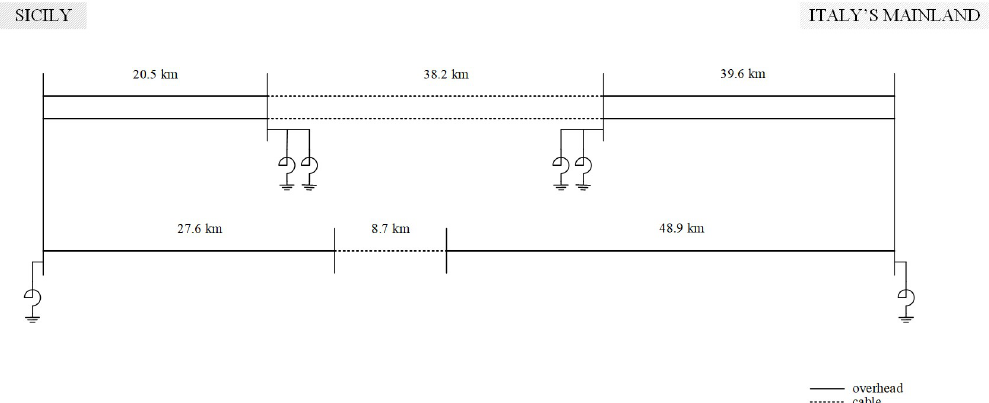
Figure 7. Single line diagram of existing 400 kV interconnections between Sicily and Italy’s mainland. Overhead sections are indicated with continuous lines; cable sections are indicated with dashed lines.